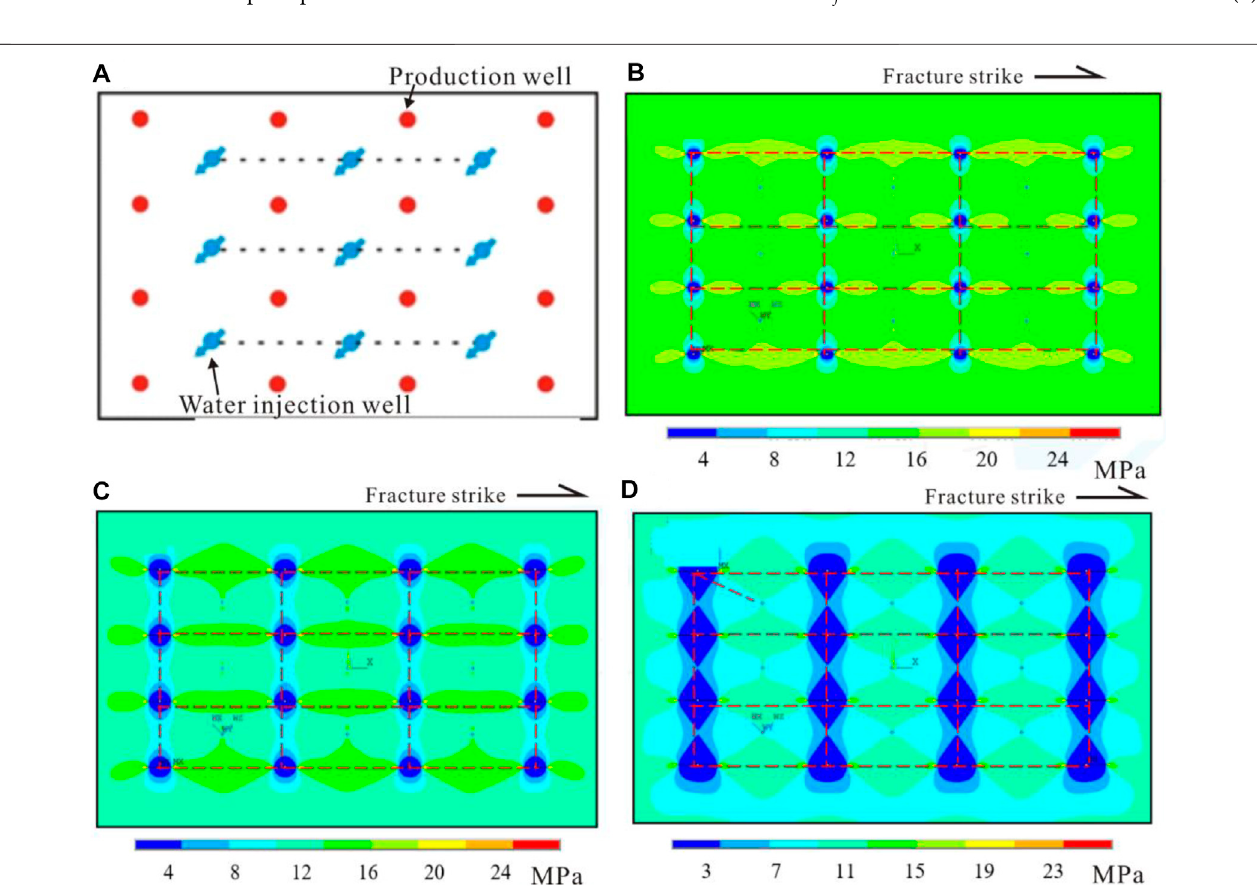
FIGURE13| Simulationresultsofpressurechangesatdifferenttimesbasedonwellpatterndesignofreverse fi ve-pointmethod. (A) Reverse fi ve-pointwellpattern design; (B) Pressure change after 10 years; (C) Pressure change after 20 years; (D) Pressure change after 30 years.